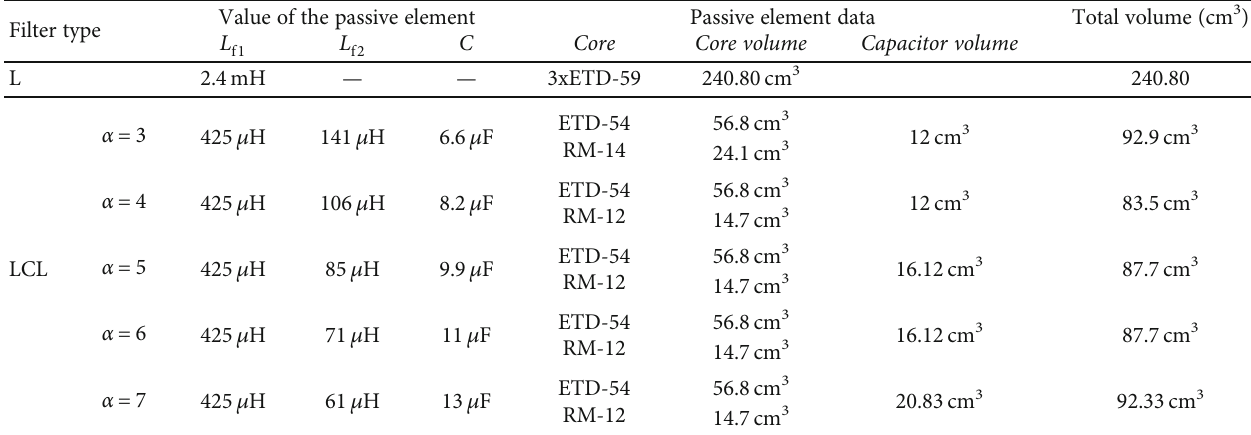
Table 9: L and LCL fi lter